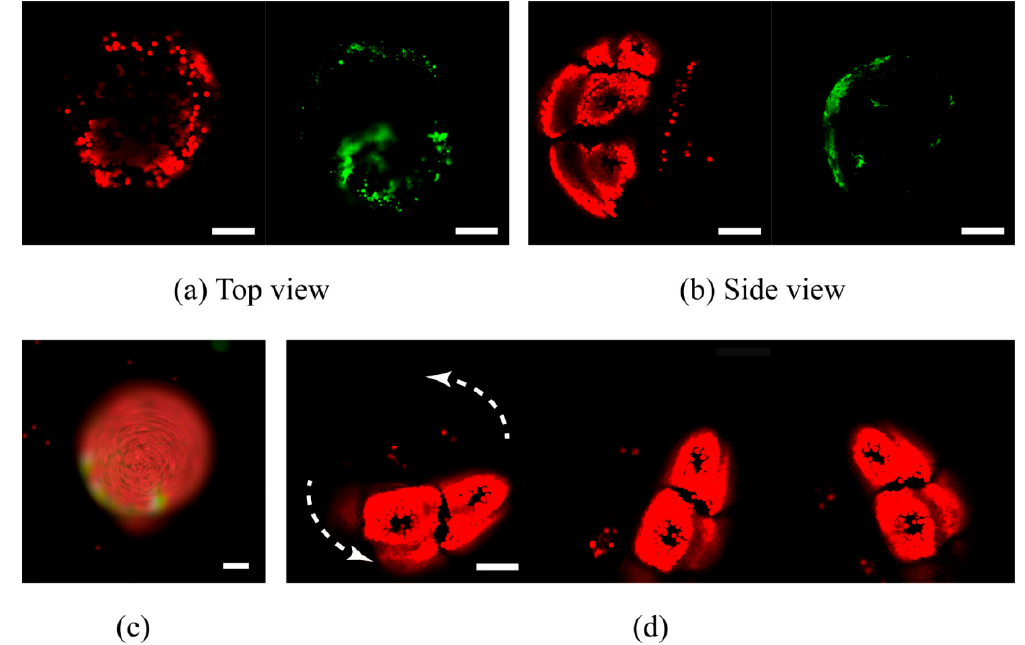
Figure 5. Confocal images of the individual coral polyp cultured in the microfluidic chip. ( a ) Top view and ( b ) side view. The autofluorescences came from the native green fluorescent proteins in the coral polyp (green) and algal chlorophyll (red). ( c ) Image of the coral polyp in the camera mode after culture in the microfluidic chip for 3 days ( d ) Confocal images confirmed the movement of the coral polyp in the microwell. All the scale bars are 100 μ m.